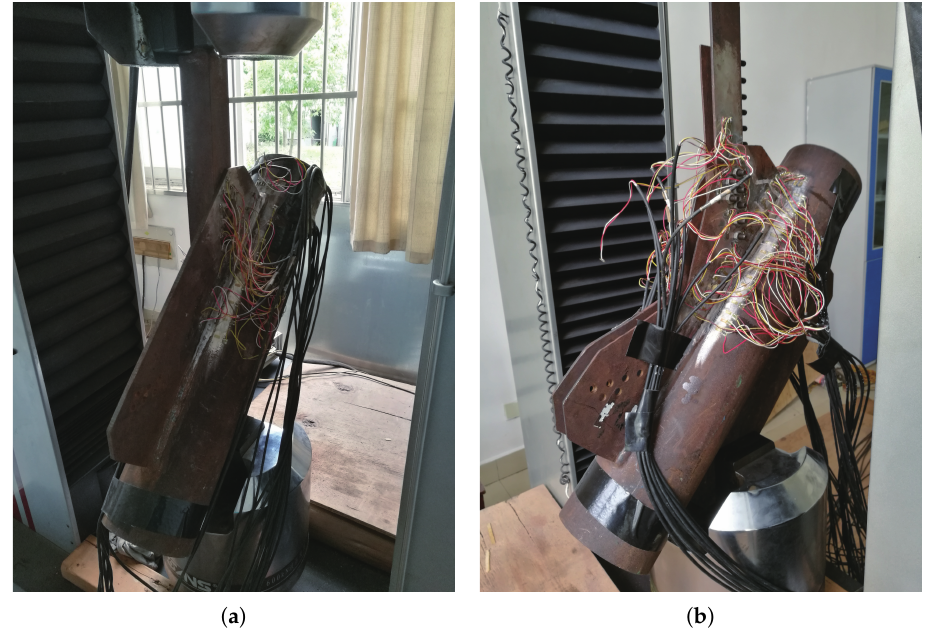
Figure 16. ( a ) The SLSPJ model. ( b ) The DLDPJ model. Table 1. Load classifications of the specimens of SLSPJ and DLDPJ.